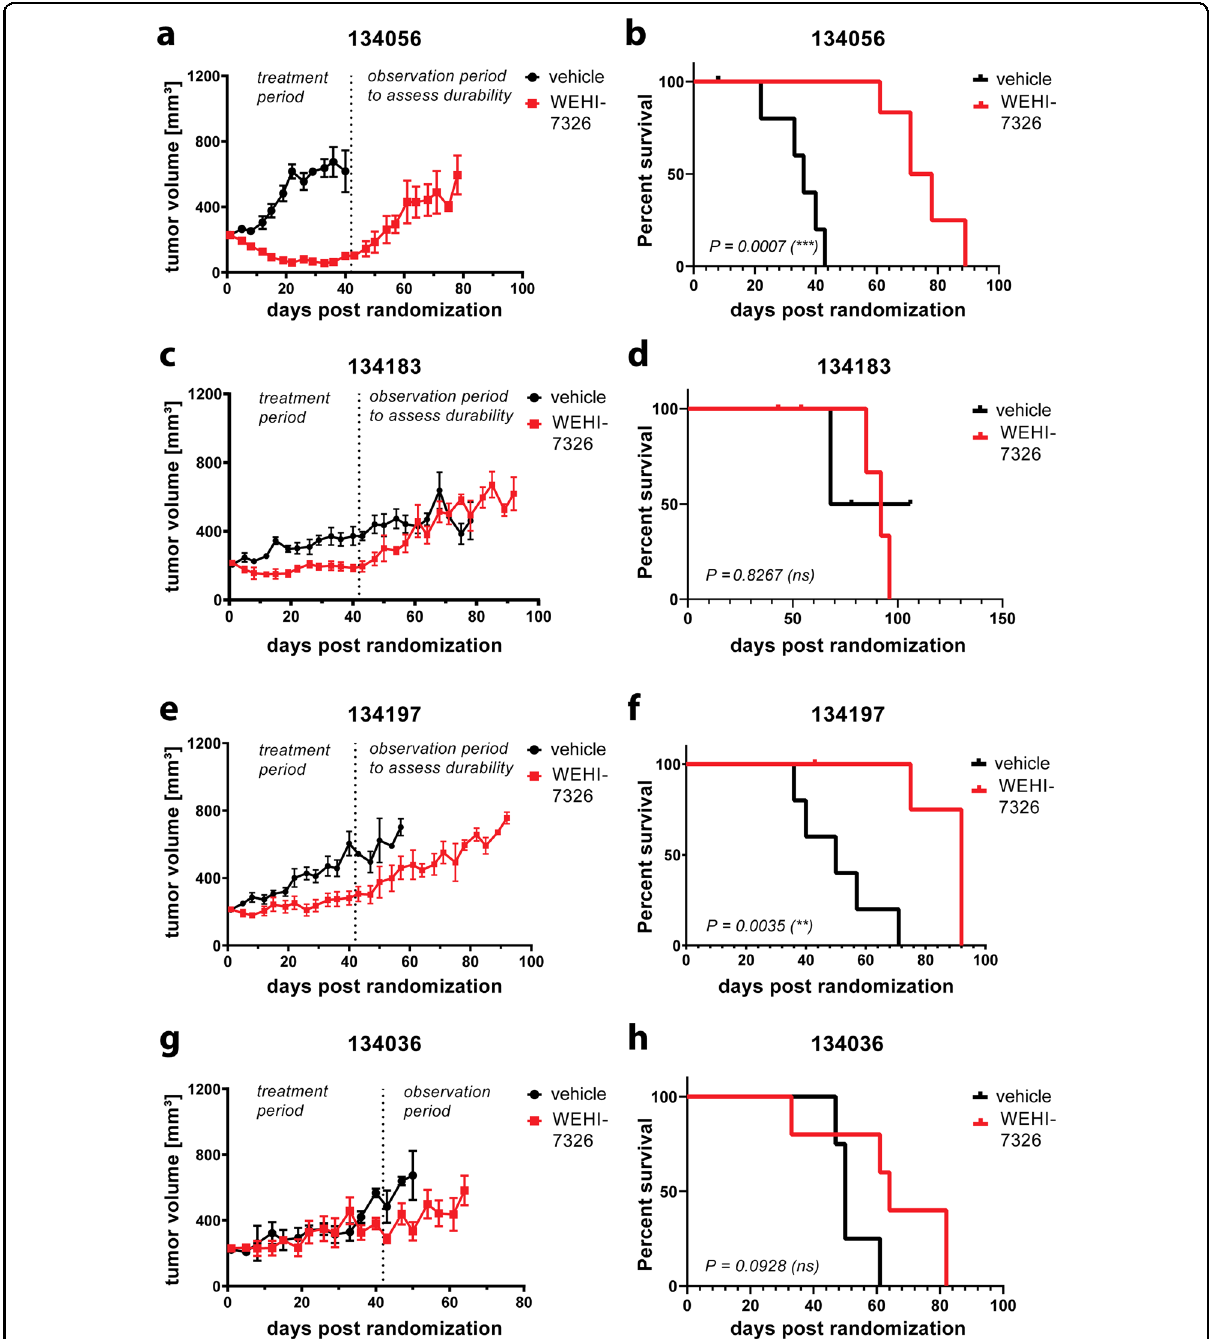
Fig. 6 Response of chemo-naïve and chemo-resistant human high-grade serous ovarian cancer to WEHI-7326 in a PDX mouse model. PDX models of HG-SOC in recipient female mice: tumor growth curves and corresponding Kaplan – Meier survival plots for ( a , b ) chemo-naïve PDX tumor line 134056 (BRCA2 mutant), ( c , d ) the chemo-naïve PDX tumor line 134183 (Rad51C methylated), ( e , f ) 134197 (genotype unknown, platinum resistant PDX) and ( g , h ) 134036 (C5 PDX, platinum refractory). Each model was treated for 6 weeks with either vehicle or WEHI-7326 (20 mg/kg; twice a week) via tail vein injection, followed by an observational period. Ethical endpoint was tumor size >700 mm 3 ; when mice had to be culled not due to tumor size (illness, weight loss or found dead) data from these mice were removed from the experiment. Displayed are p -values compared to vehicle obtained through Log-rank (Mantel – Cox)